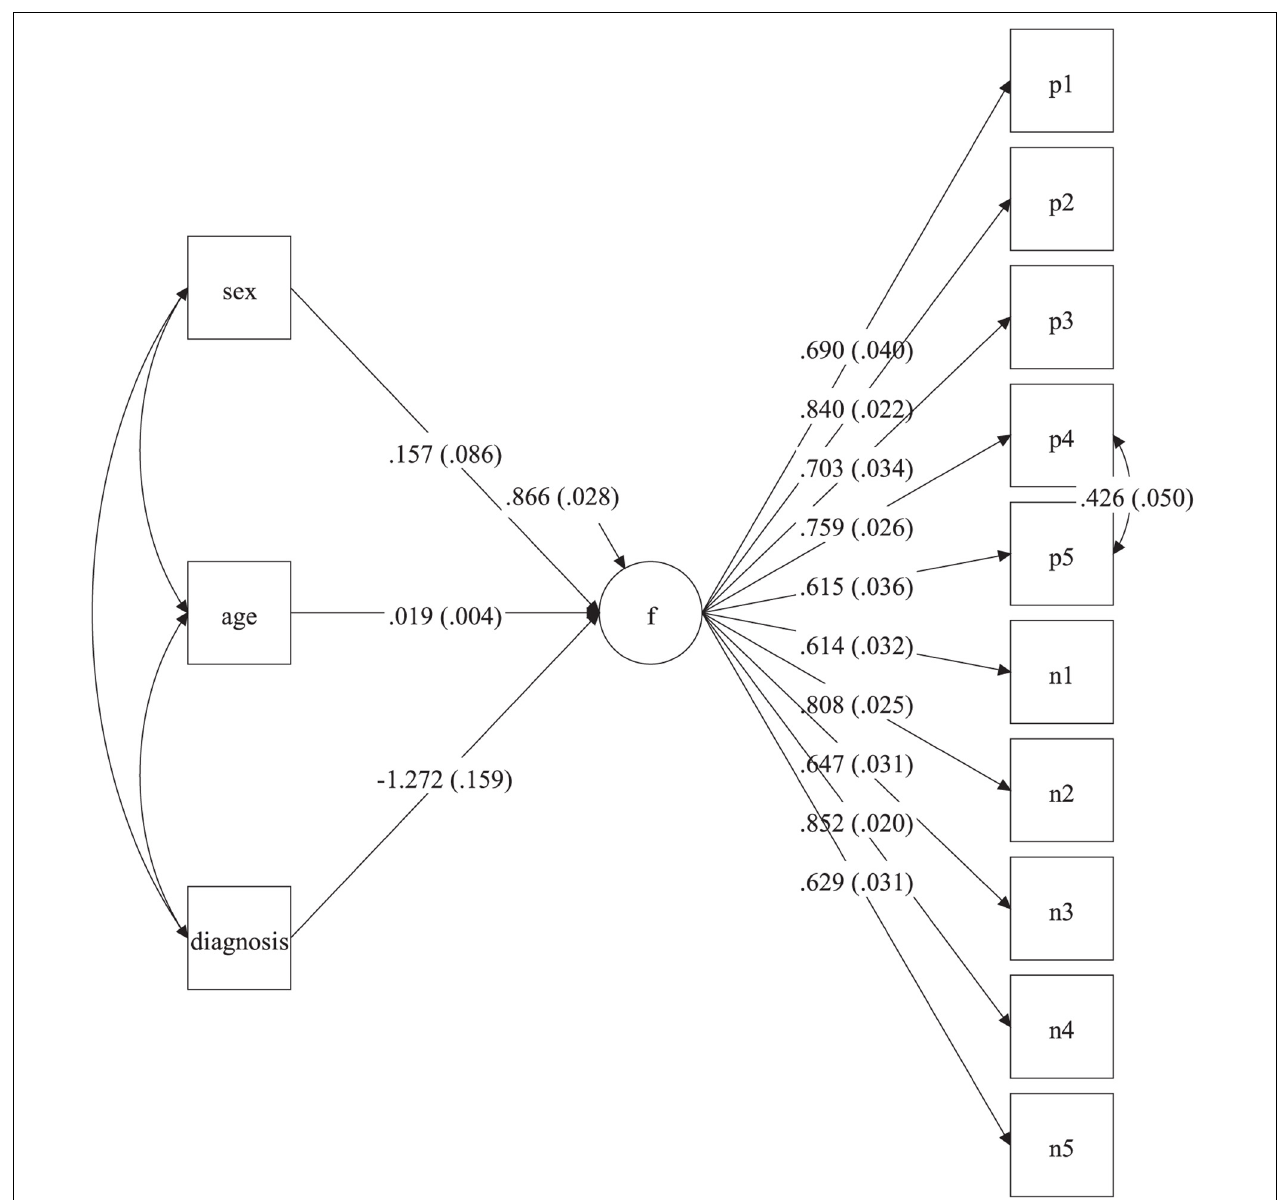
FIGURE 4 | SEM MIMIC model for the prediction of self-esteem. f, self-esteem factor; p1–p5, positive items; n1–n5, recoded negative items; sex (0 = men, 1 = women); diagnosis, psychological diagnosis (0 = no, 1 = yes). Values in parenthesis indicate standard errors. Estimates correspond to the solution with the latent factor (f) standardized. p < 0.001 for all factor loadings and the age and diagnosis regression weights. p = 0.069 for the sex regression weight. p < 0.001 for the explained variance of the self-esteem